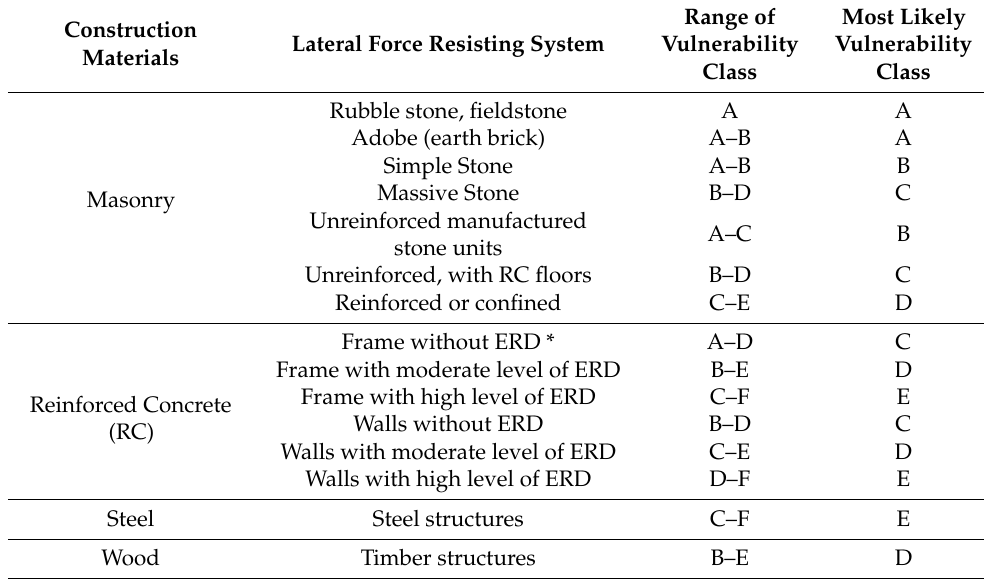
Table 1. Vulnerability class for different structures (EMS-98).